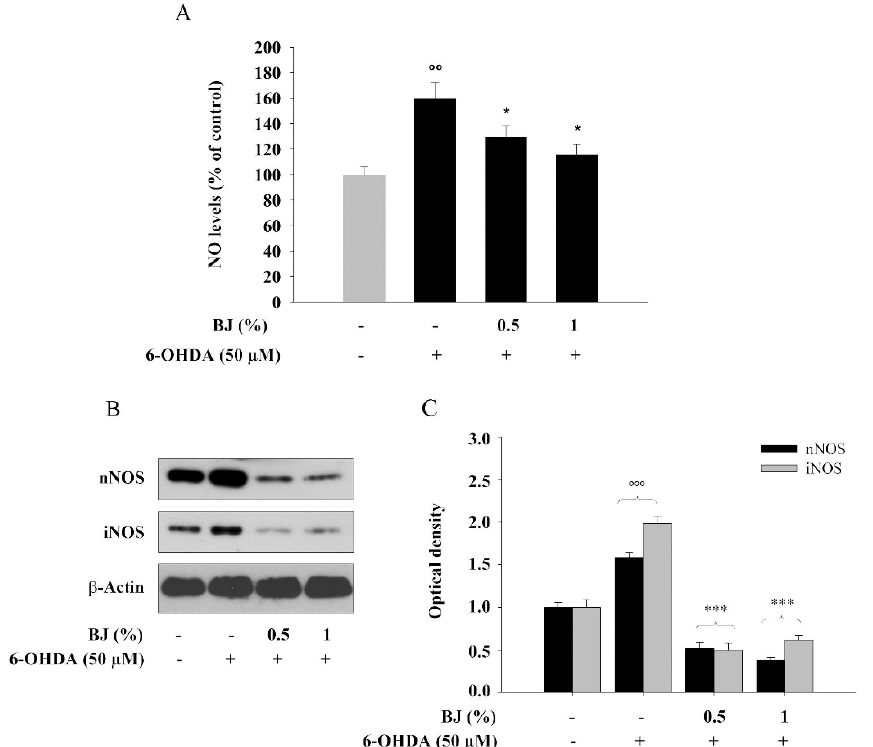
Figure 8. BJ prevents the 6-OHDA-induced NO release and reduces the expression of nNOS and iNOS. ( A ) Differences in NO production found in cells either or not pre-treated with BJ and then exposed to the 6-OHDA are reported as percentage of NO value detected in treated cells compared to those found in untreated ones. The levels of NO were measured by a colorimetric assay. Results are expressed as means ± S.E.M. from three independent experiments. ( B ) Levels of nNOS and iNOS proteins from cell cultures treated as described above, were determined by western blot analyses. Representative immunoblots are shown. ( C ) Densitometric analysis of blots from three different experiments (mean ± S.E.M.) is presented. °°° P < 0.001 and °° P < 0.01 vs. control; * and *** P < 0.05 and P < 0.001 vs. 6-OHDA treated cells, respectively.